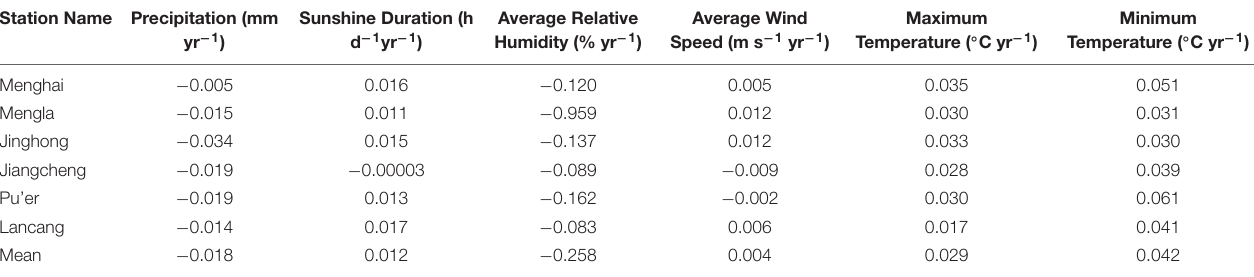
TABLE 3 | Interannual variation trend of meteorological elements at each meteorological